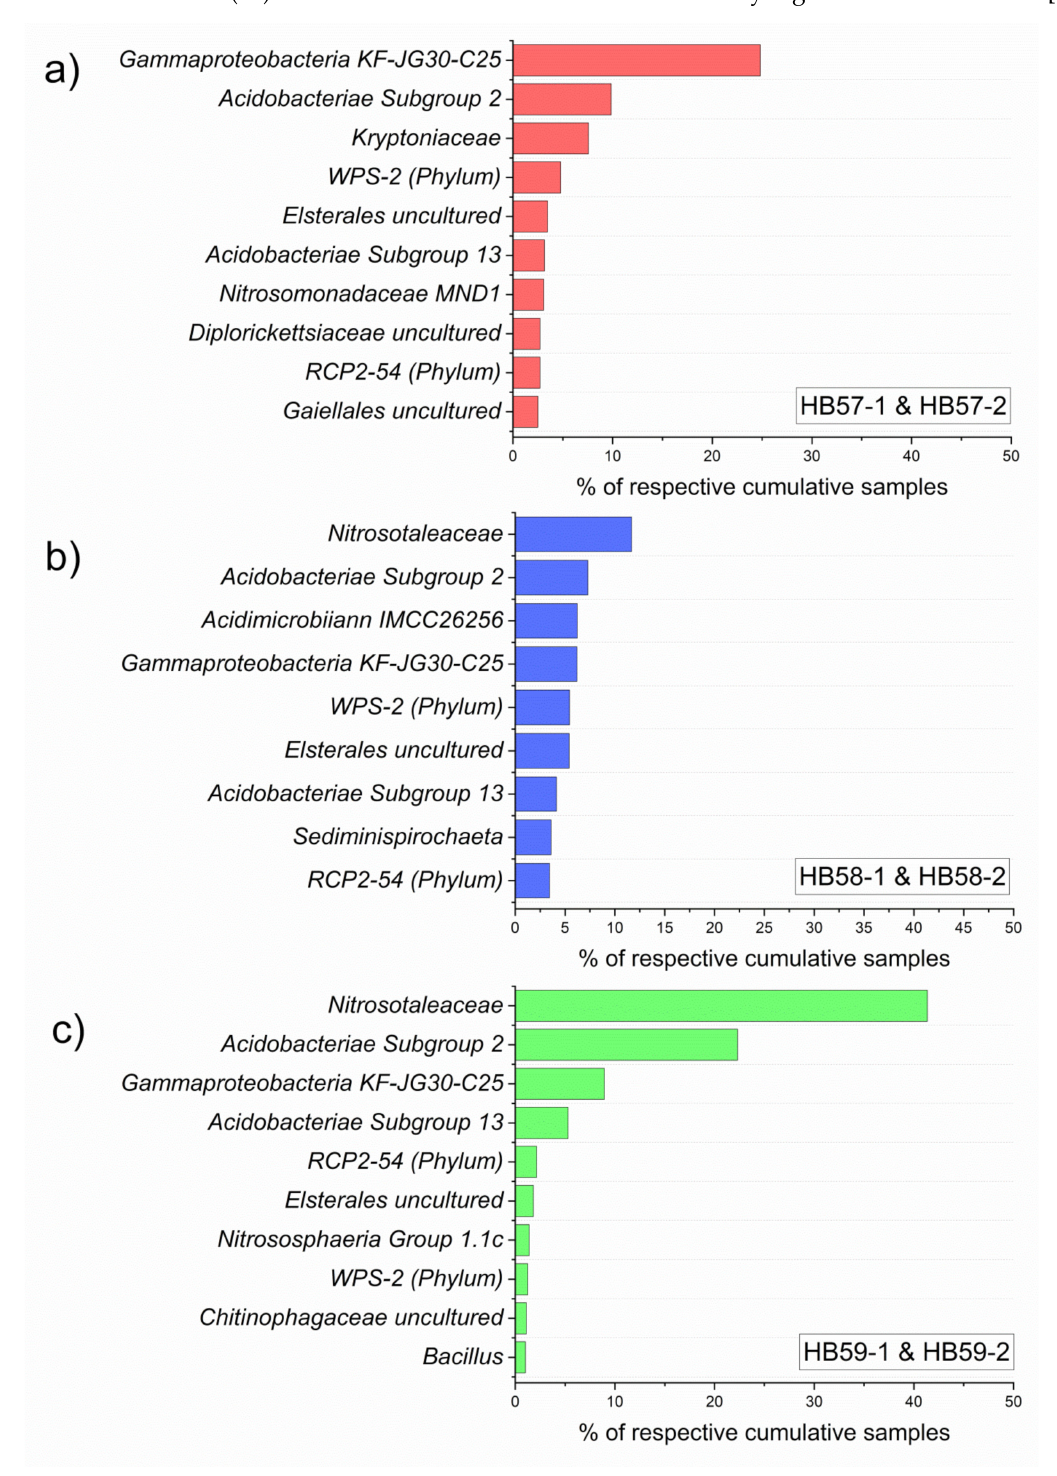
Figure 8. Selected species with high abundance. This column chart shows the members of the most dominant OTUs from the three sampling sites: ( a ) coal seam, samples HB57-1 and HB57-2; ( b ) bright sediment, samples HB58-1 and HB58-2; ( c ) topsoil, HB59-1 and